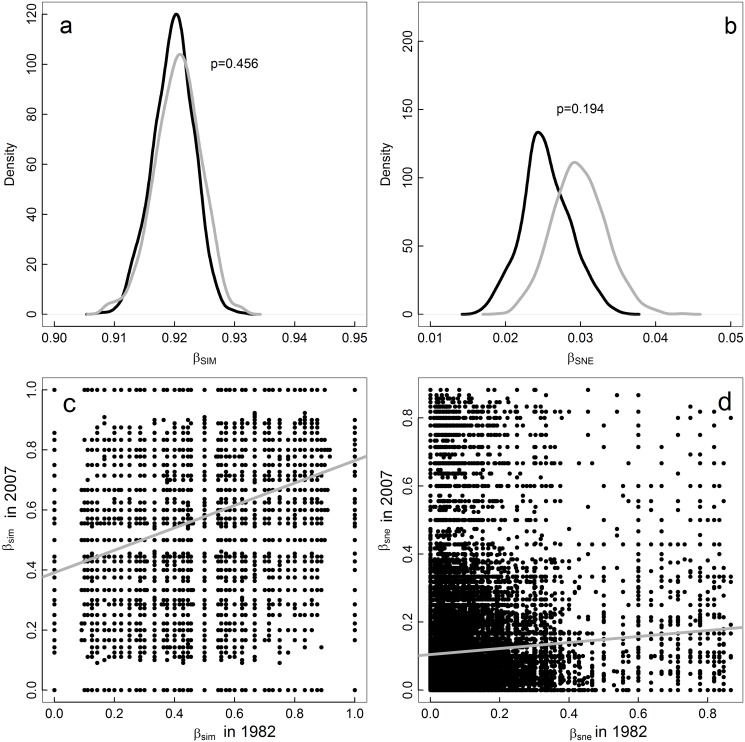
Temporal variation in spatial beta diversity.(a) and (b) show the distribution of multiple site dissimilarity in 1982 (black) and 2007 (gray) for the turnover (βSIM) and nestedness-resultant (βSNE) components, respectively, after resampling multiple-site dissimilarity values for 50 localities 1000 times. (c) and (d) show the correlation between spatial pairwise dissimilarity in 1982 and spatial pairwise dissimilarity in 2007 for the turnover (βsim) and nestedness-resultant (βsne) components, respectively. The gray lines are the linear fits.